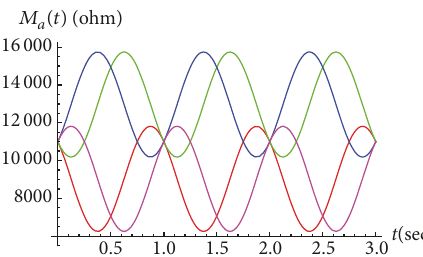
Figure 22: 𝑀 𝑎 (𝑡) of the fractional order memristor under the sinusoidal input with 𝐼 𝑚 > 0 : 𝜃 = 45 ∘ (red), 𝜃 = 135 ∘ (green), 𝜃 = 225 ∘ (blue), and 𝜃 = 315 ∘ (magenta).